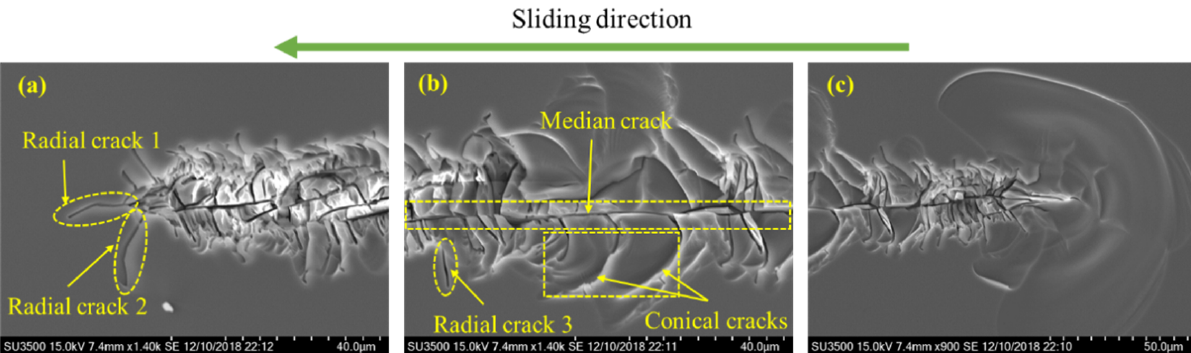
Figure 18. The SEM images of the impression at the ( a ) end, ( b ) middle, and ( c ) start of the edge- forward Berkovich scratching, under the normal load of 600 mN.